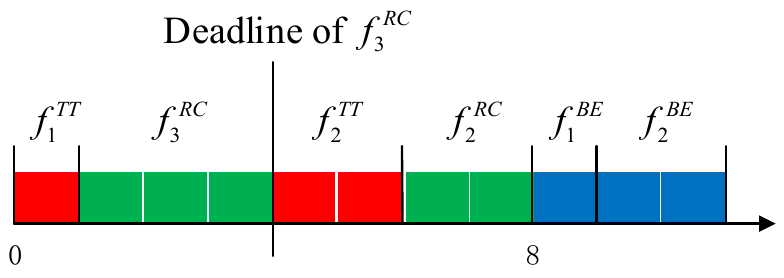
Figure 6. Example of shaping in ascending order of traffic laxity.